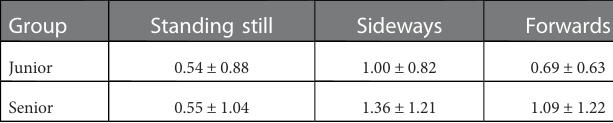
TABLE 1 Mean (±SD) number of blocked balls during the different levels of opposition per